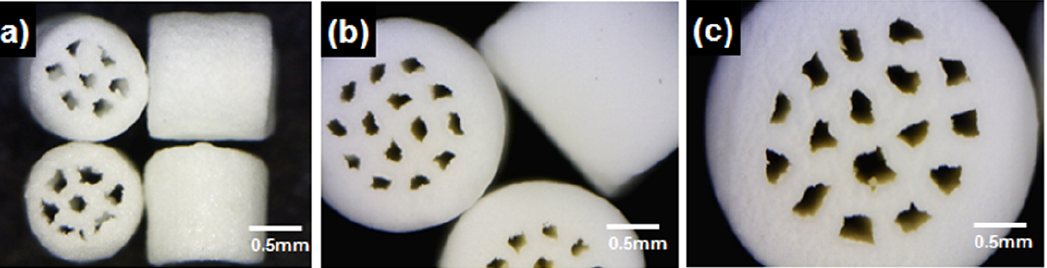
Figure 1. Optical micrographs of different size multichannel granular bone substitutes. ( a ) 1 mm diameter, ( b ) 2 mm diameter and ( c ) 3 mm diameter.